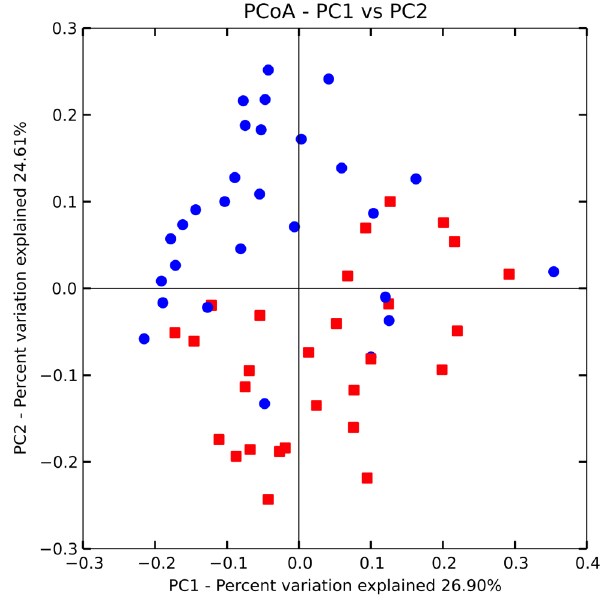
Figure 3. Principal Coordinates Analysis of weighted UniFrac distances for 16S rRNA gene sequence data. The distribution N shows distances within and across normal-weight (N, red & ) and obese ) subjects populations on the basis of the (O, blu